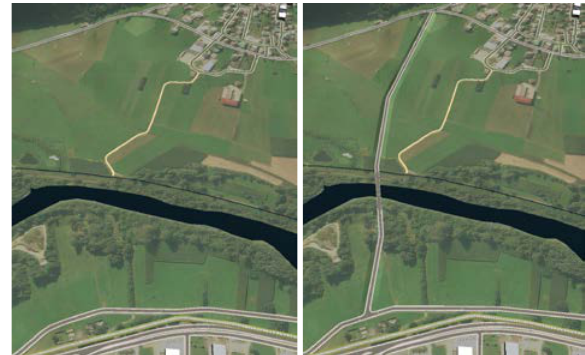
Figure 3. The area with (right) and without (left) the new road designed via parametric modelling.